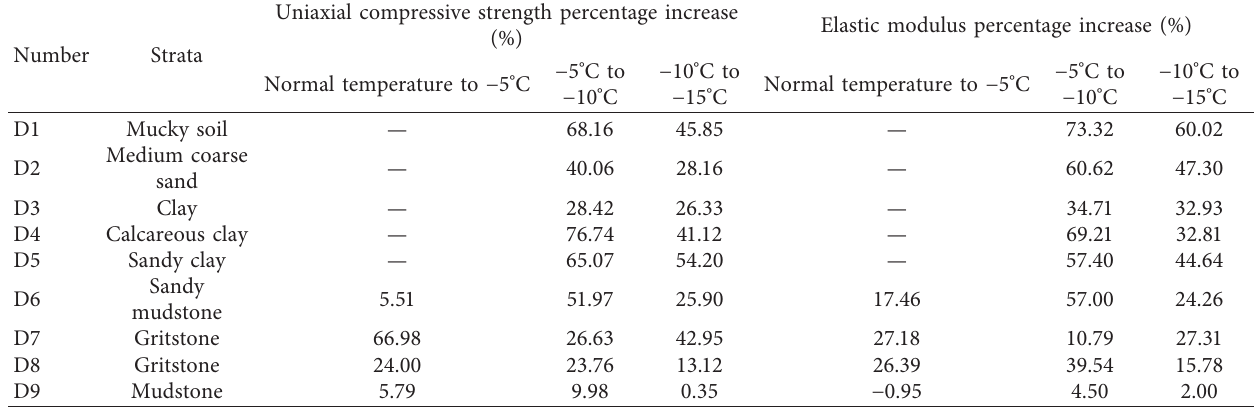
Table 4: Percentage increases in sample strength parameters for different temperature changes.